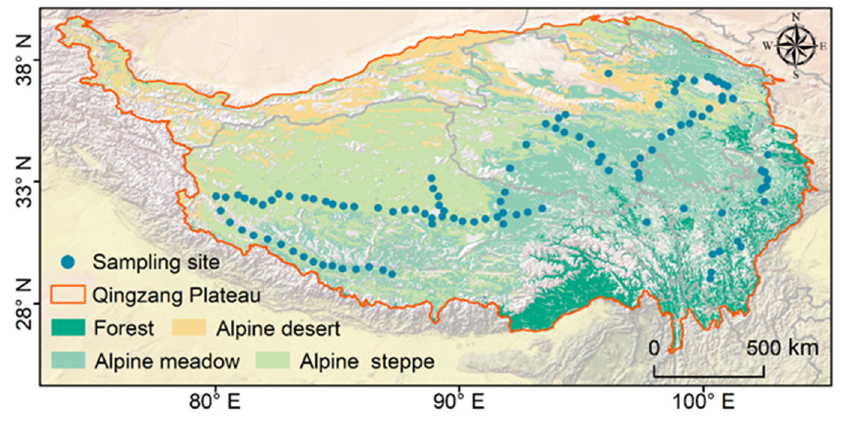
Figure 1. Geographical information of the QingZang Plateau, including border, sampling sites in 2015, and major ecosystem types.